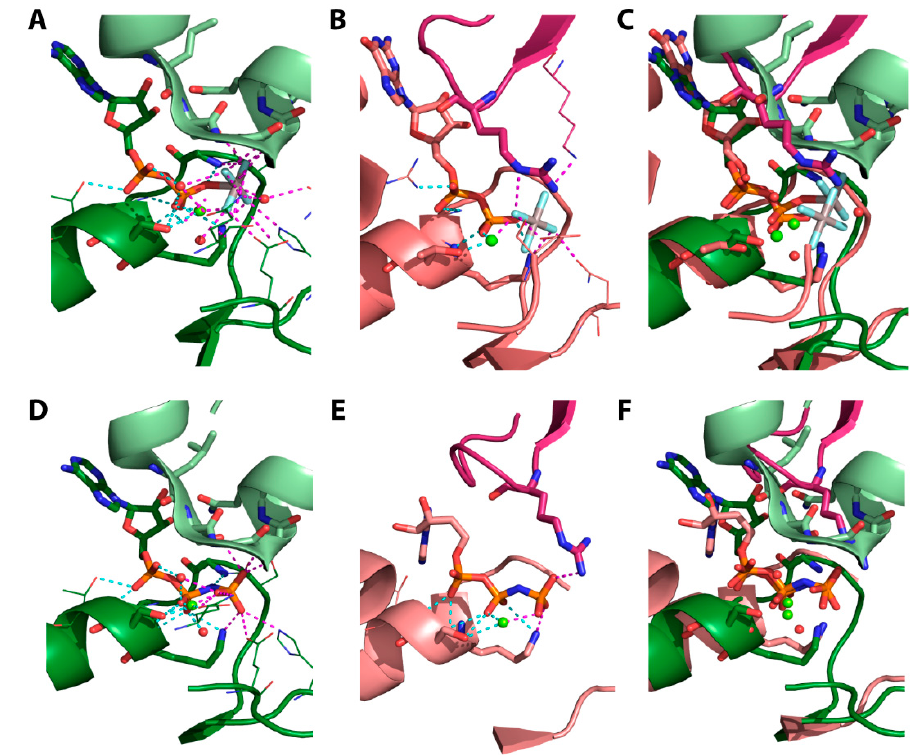
Figure 11. Structural comparison of nucleotide-binding sites in SF4 helicases and ABC-transporters. Different protein subunits are colored in different shades of the same color. Mg 2+ or Ca 2+ ions are shown as green spheres; water molecules are shown as red spheres; hydrogen bonds and metal interactions involving α - and β -phosphates are shown as cyan dashes, interactions with γ -phosphate or its fluoroaluminate complex mimic shown as magenta dashes. Nucleotide analogue, P-loop motif residues and activating residues (Arg residue or LSGGQ motif) are shown as thick sticks, other interacting amino acid residues are shown as thin sticks. Enzymes complexed with NDP:AlF 4- ( A – C ). Maltose/maltodextrin import ATP-binding protein MalK from Escherichia coli K-12 (PDB ID 3PUW, chain B) ( A ), Replicative helicase DnaB from Geobacillus stearothermophilus (PDB ID 4ESV, chain E) ( B ), Structures 4ESV and 3PUW superimposed by phosphate chain and ribose atoms of NDP moieties ( C ); Enzymes complexed with the slowly hydrolyzable ATP analogue AMPPNP ( D – F ). Maltose/maltodextrin import ATP-binding protein MalK from Escherichia coli K-12, (PDB ID 3RLF, chain A) ( D ), Gene 4 Ring Helicase from Escherichia phage T7 (PDB ID 1E0J, chain A) ( E ), Structures 1E0J and 3RLF superimposed by phosphate chain ( F ).